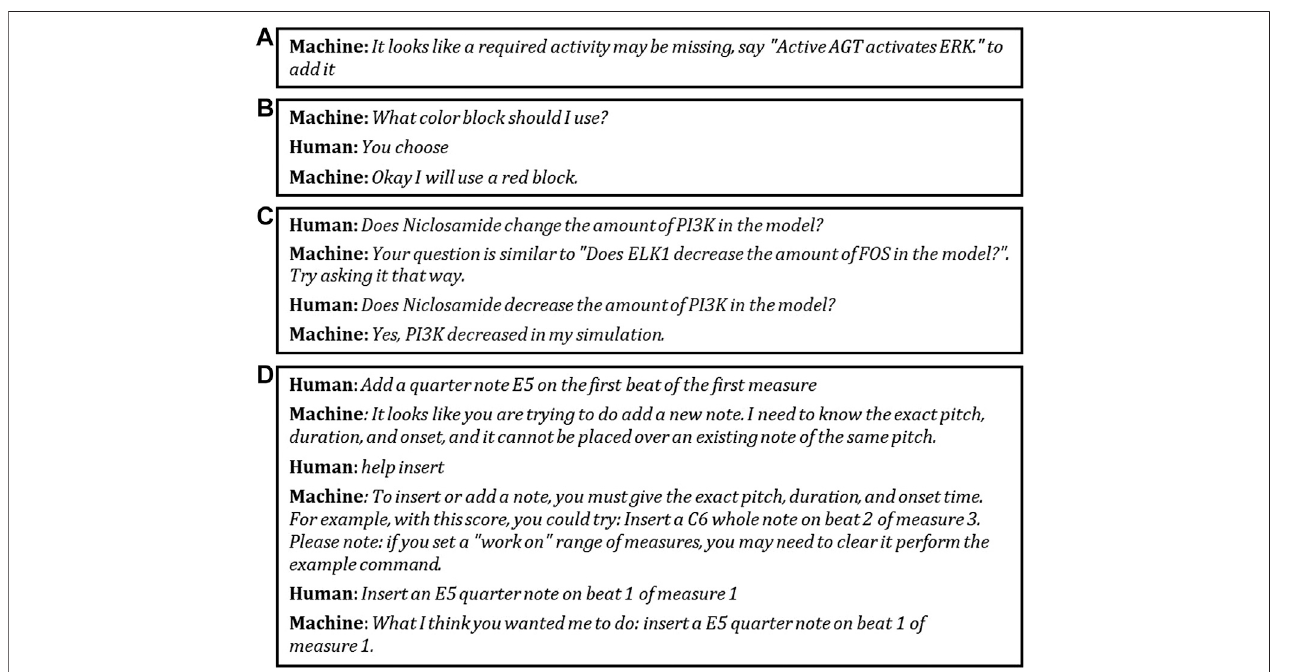
FIGURE1| Initiative,autonomy,andshaping:Machinepartners (A) takeinitiative, (B) acceptofferedautonomy,andin (C) and (D) helpshapethehumanpartners ’ utterances. As described in the text, these examples demonstrate Hallmarks MC-4, MC-5, HA-1, and HA-2. The text for panel (A) was provided by the Bob with Bioagents system. The text for panel (B) was provided by Paul Cohen (Paul Cohen, personal communication, 2017). The text for panel (C) was provided by the CLARE system. The text for panel (D) was provided by the MUSICA